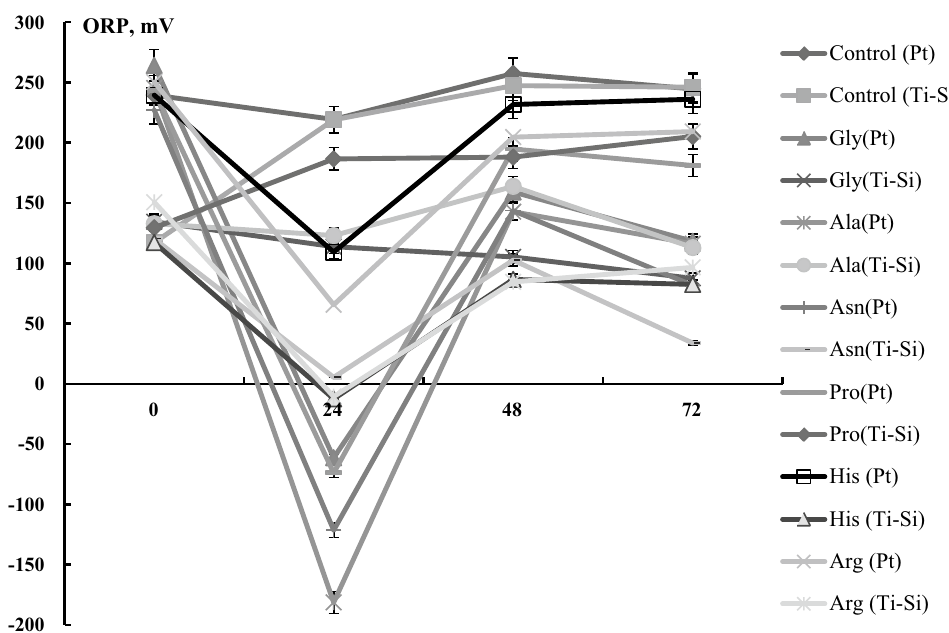
Fig. 5 L-AAs influence on the kinetics of ORP of R. eutropha H16. Bacteria were grown aerobically, at pH 7.0, for 72 h, n measured by using Pt and Ti-Si electrodes. For the other details, see Materials and methods and the legends in Figs. 1,